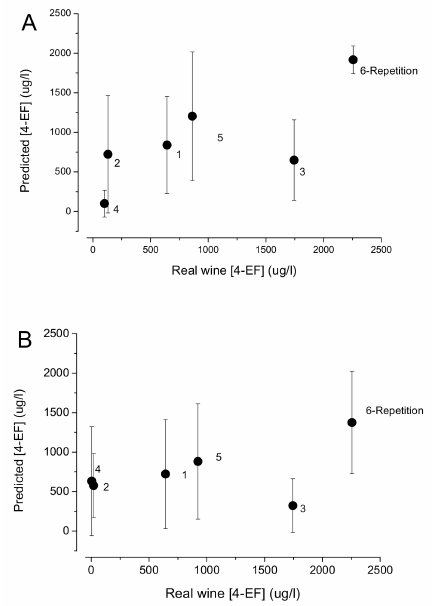
Figure 5. Relation between the real chemical concentration of 4-ethylphenol and the respective predicted concentration given by two different tasting panels (( A ) DOC certification office; ( B ) faculty enology students). Wines from 1 to 5 are commercial brands. Wine 6 is a blank sample spiked with of 4-ethylphenol (2000 µ g/L) and 4-ethylguaiacol (250 µ g/L). Vertical bars indicate standard